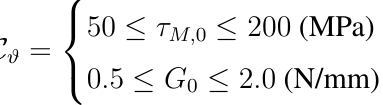
, whereas the circles denote the final 0